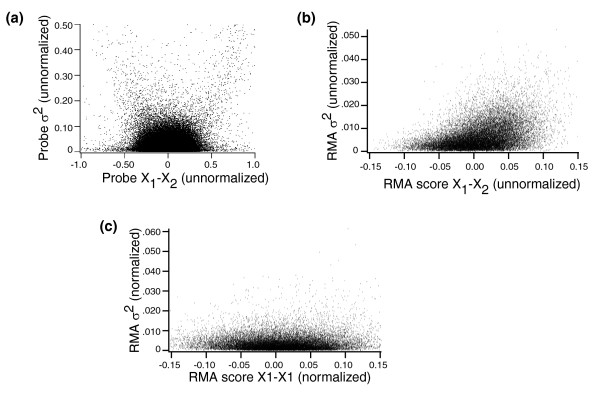
Standard error as a function of the difference in means. Shown is σ2 as a function of x¯1−x¯2
 MathType@MTEF@5@5@+=feaafiart1ev1aaatCvAUfeBSjuyZL2yd9gzLbvyNv2Caerbhv2BYDwAHbqedmvETj2BSbqee0evGueE0jxyaibaiKI8=vI8tuQ8FMI8Gi=hEeeu0xXdbba9frFj0=OqFfea0dXdd9vqai=hGuQ8kuc9pgc9s8qqaq=dirpe0xb9q8qiLsFr0=vr0=vr0dc8meaabaqaciGacaGaaeqabaqadeqadaaakeaaieaaceWF4bGbaebadaWgaaWcbaGaaGymaaqabaGccqGHsislceWF4bGbaebadaWgaaWcbaGaaGOmaaqabaaaaa@381E@ (see Equation 1 in the text) for probes from null genes from the comparison of Latin Square experiments 1 and 2 for (a) all approximately 500,000 probes on the array, (b) approximately 22,000 probes after RMA summation but in the absence of quantile-quantile normalization, and (c) after background correction, quantile-quantile normalization, and RMA summation. A small number of outlying data points are excluded from each panel. RMA, Robust Multichip Average.